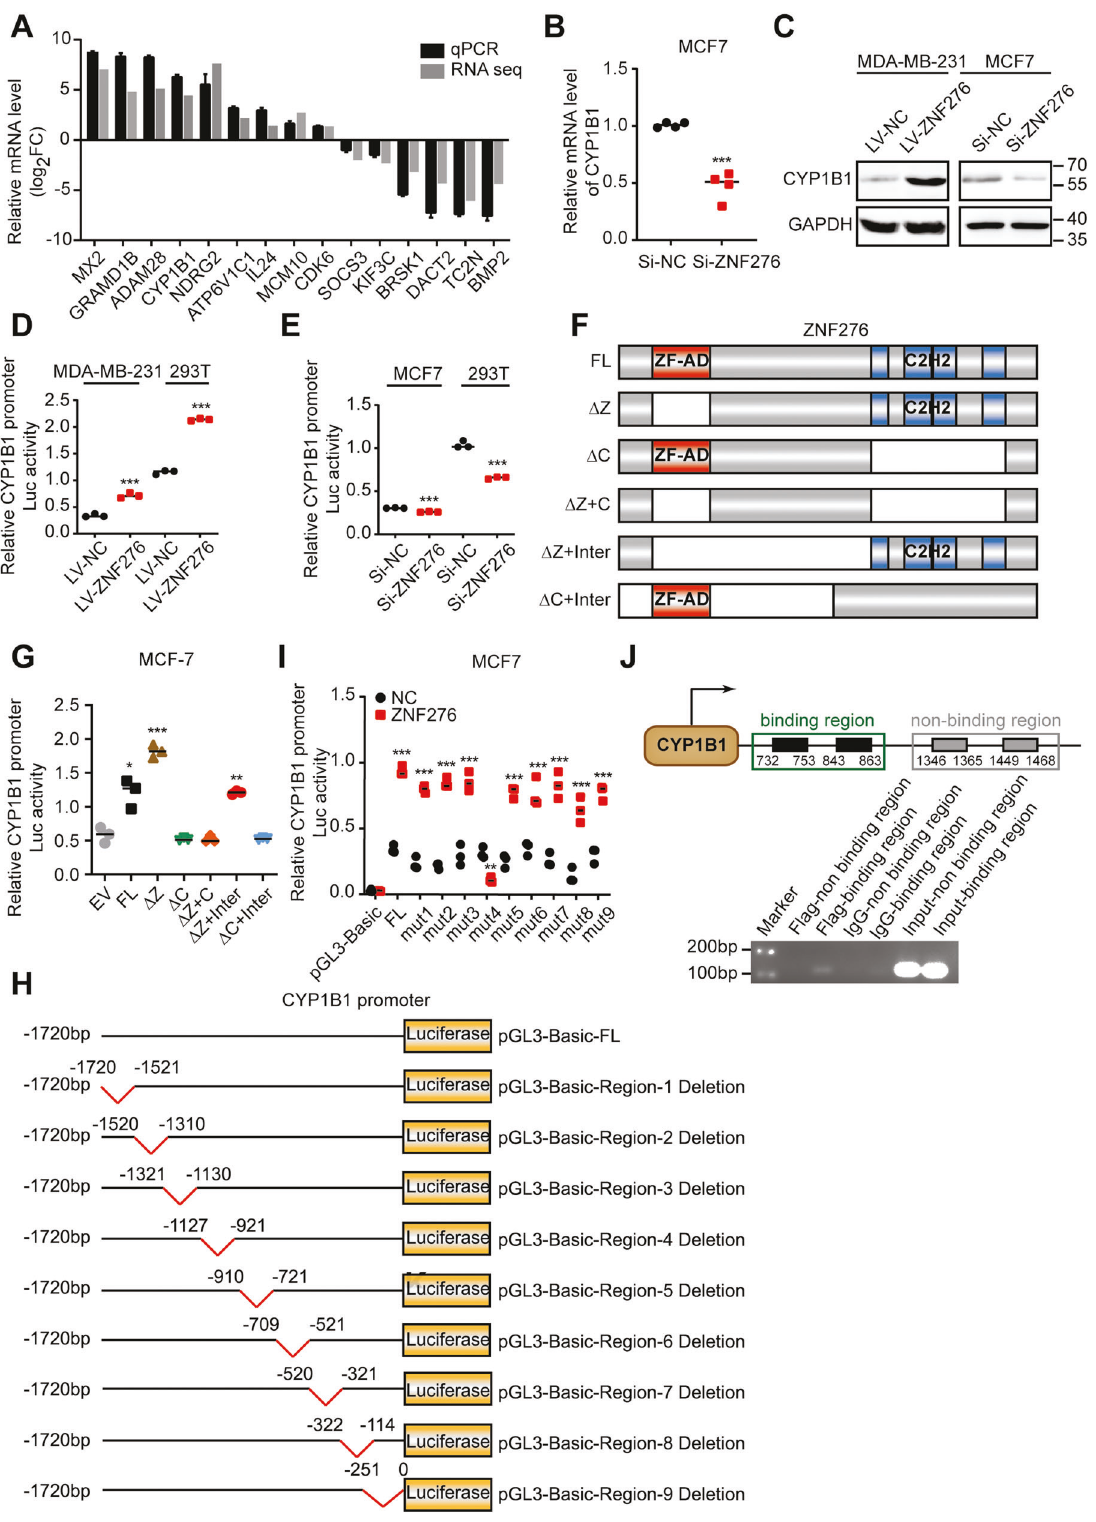
Fig. 4 ZNF276 regulates CYP1B1 promoter transcriptional activity. A The mRNA levels of the 15 genes with relative high fold change were veri fi ed by RT-qPCR. B The effect of ZNF276 knockdown on the mRNA expression of CYP1B1. C Western blot analysis of the effect of ZNF276 overexpression and knockdown on CYP1B1 expression. D Dual-luciferase reporter gene assay showing ZNF276 overexpression promoted luciferase activity of CYP1B1 promoter. E Dual-luciferase reporter gene assay showing inhibition of ZNF276 decreased luciferase activity of CYP1B1 promoter. F Construction of truncated fragments of ZNF276 for investigating the binding site of ZNF276 on CYP1B1 promoter. G Dual- luciferase reporter gene assay measuring the CYP1B1 promoter luciferase activity driven by different truncated fragment of